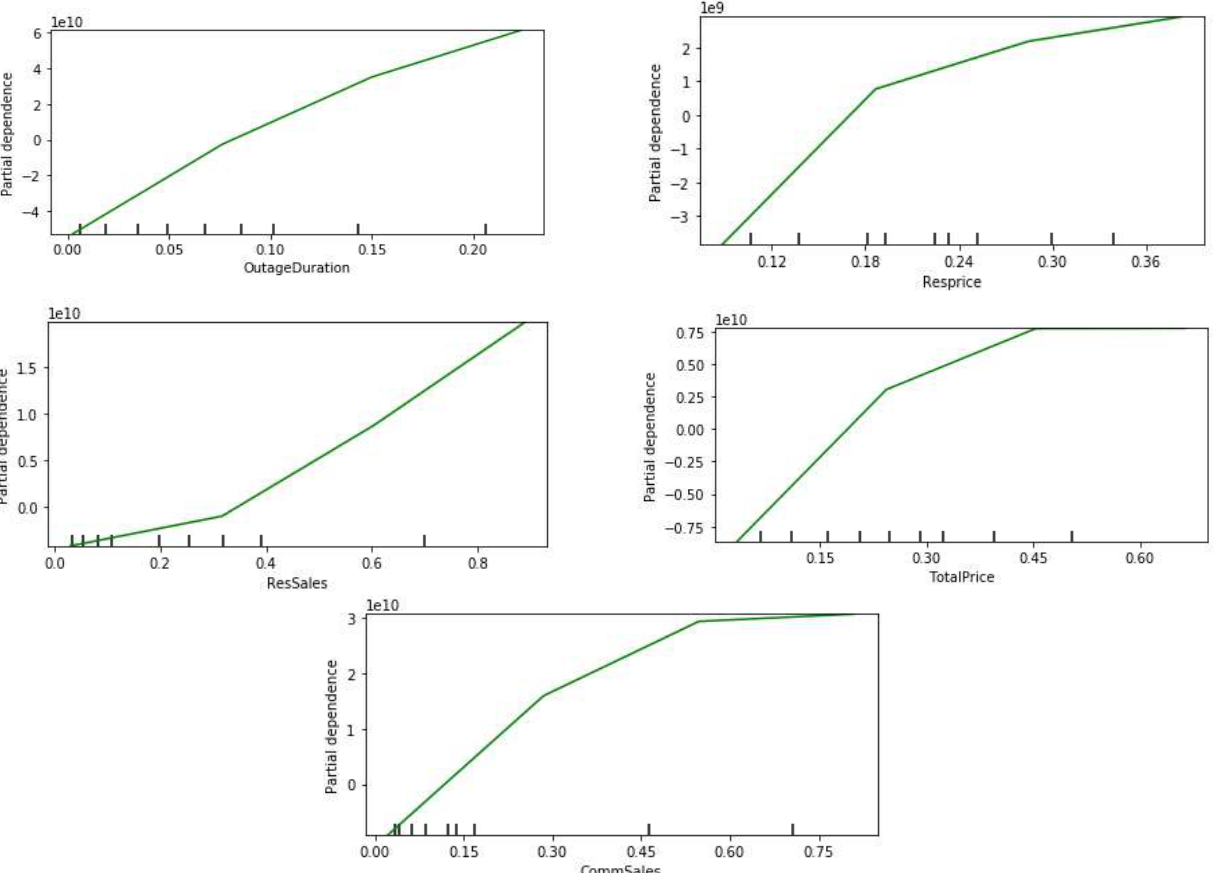
Figure 20. Partial dependency plots of top five important parameters for revenue loss prediction in the thunderstorm disaster category.